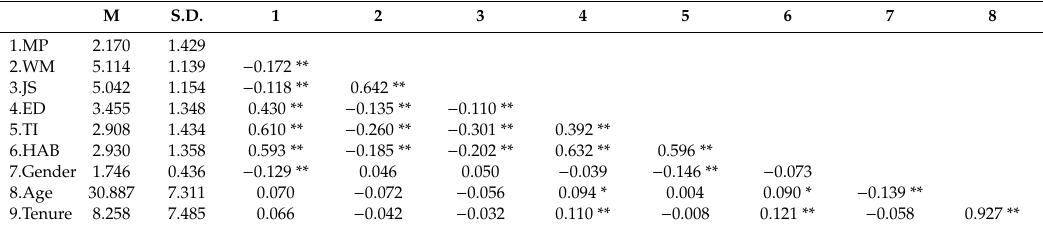
Table 1. Descriptive statistics and correlations.